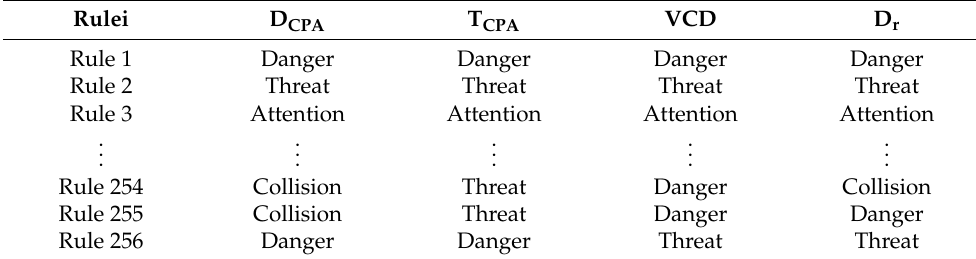
Table 1. Components of the fuzzy inference rules for FIS-NC. Rulei D CPA T